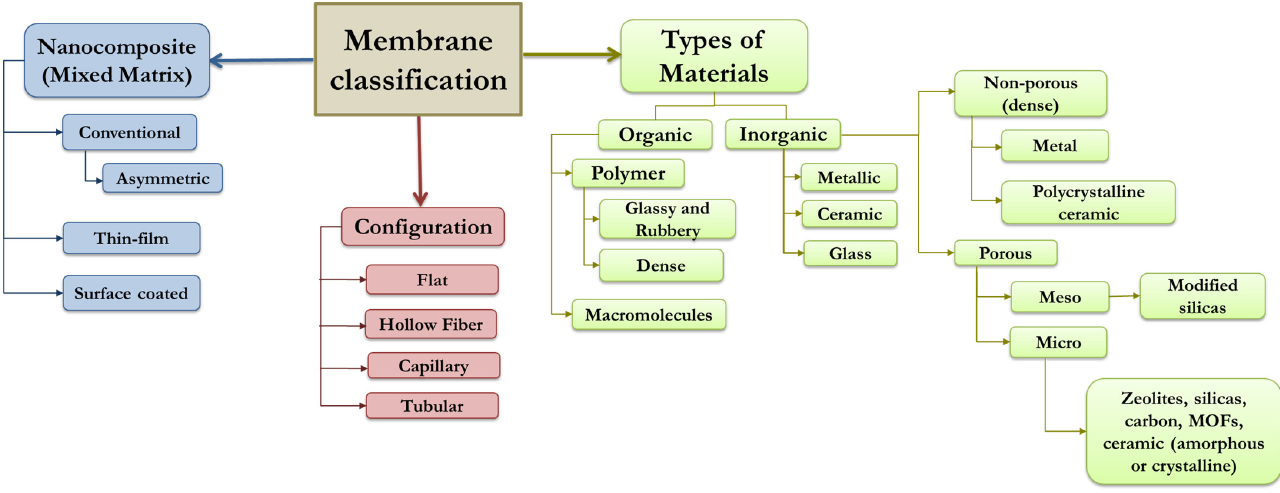
Figure 2. Classification of membranes for gas separation. Adapted from Vinoba and co-workers, 2017.